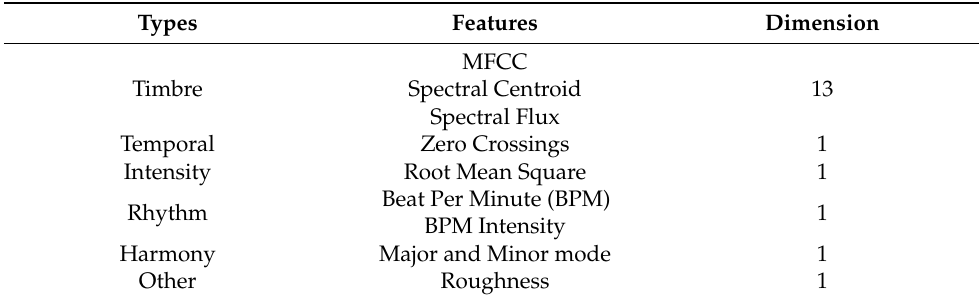
Table 4. Extracted audio feature list.